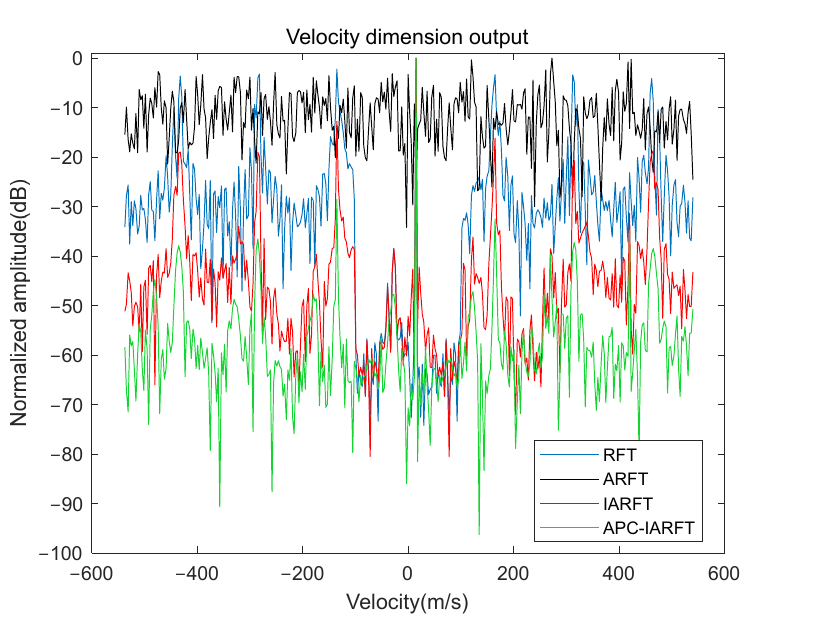
Figure 7. Velocity-dimension output of four methods in Scenario 1.